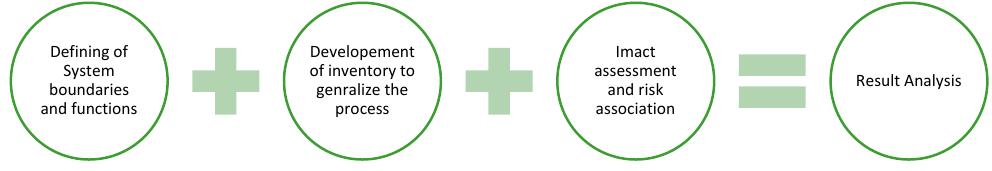
Figure 5. The steps involved in the process of life cycle assessment.